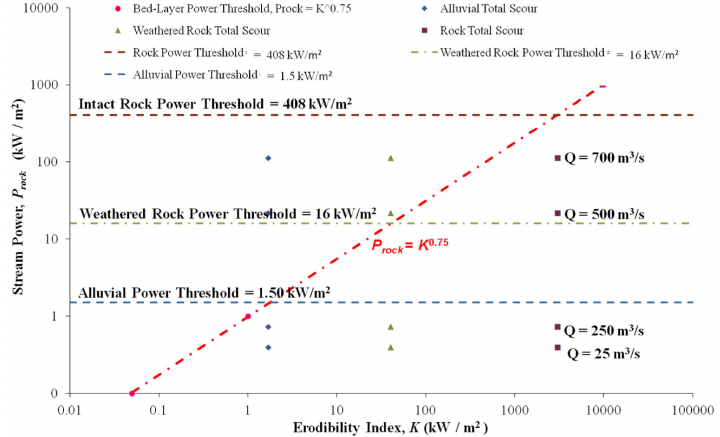
Figure 7. Stream power of the jet for different flows as a function of the erodibility. Alluvial, weathered rock and intact rock indexes ( Y s = 18 m, Y 0 = 6 m) for the free surface